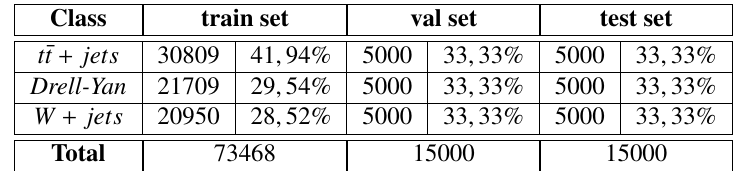
Table 1. Distribution of the number of images among the three classes we intend to classify for the train , validation and test